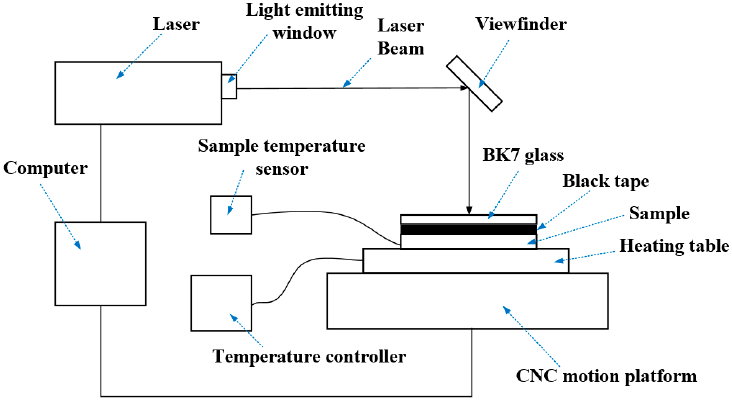
Figure 2. Schematic of the WLP process.